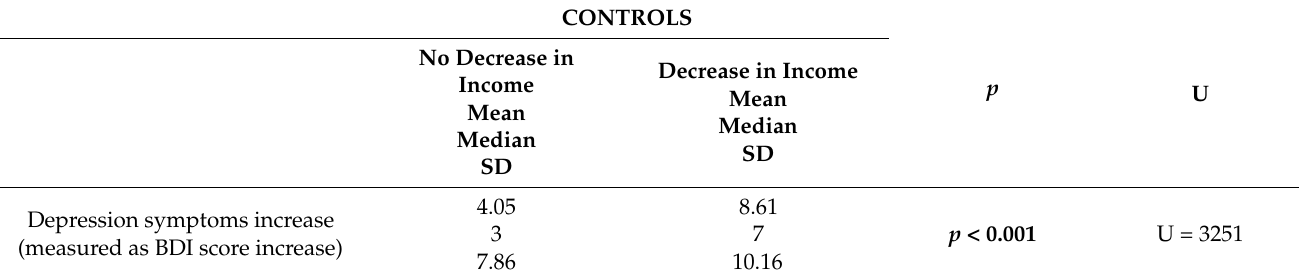
Table 4. Increase of BDI from pre-pandemic to current (during pandemic) period of time among controls depending on income change during pandemic. Mann-Whitney U